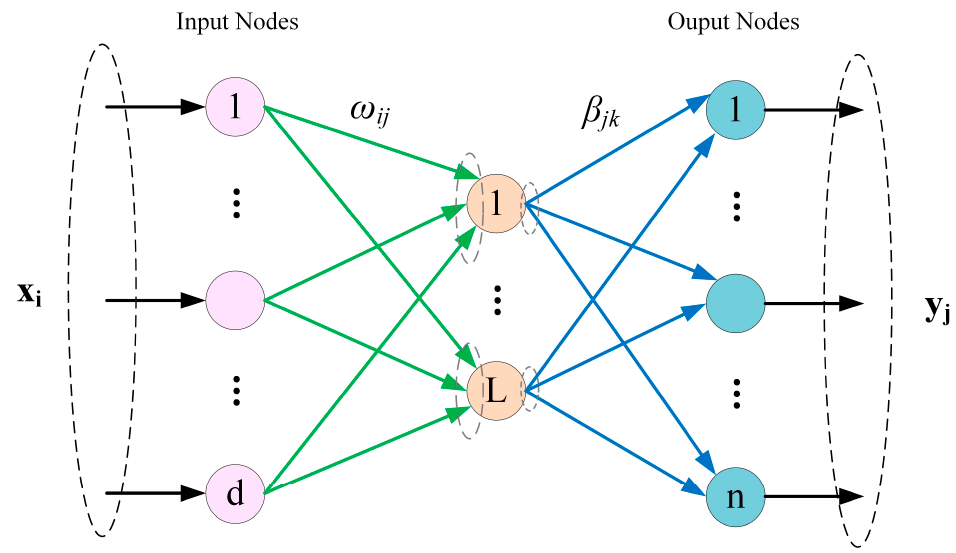
Figure 2. The ELM network structure. The algorithm has three layers: input layer with d input neurons, hidden layer with L hidden neurons, and output layer with n output